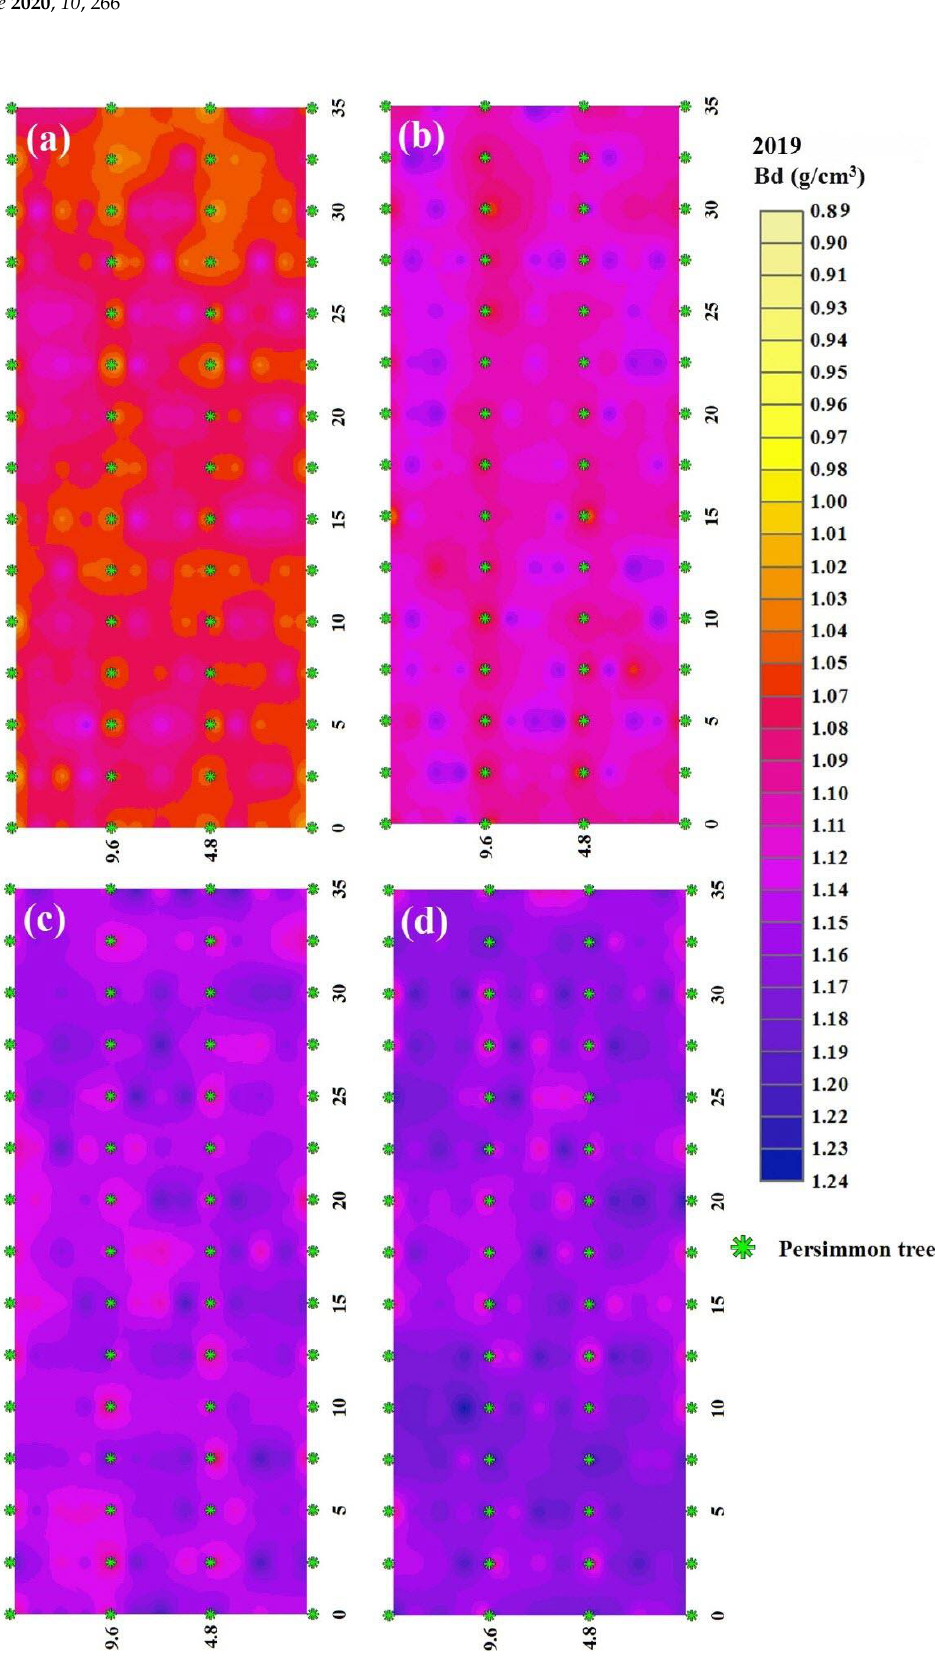
Figure 5. Spatial distribution of Bd at four depths: ( a ) 0–6 cm, ( b ) 6–12 cm, ( c ) 12–18 cm and ( d ) 18–24 cm in 2019.